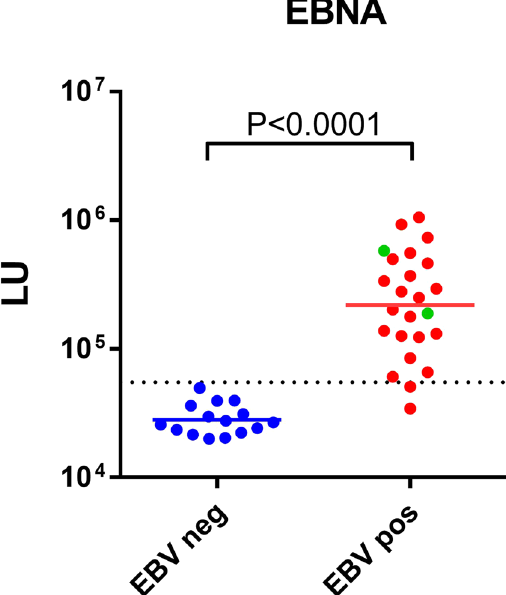
Figure 4. Diagnosis of EBV infection by LIPSTICKS. A cohort of human samples characterized for EBV infection by a commercial ELISA detecting antibodies directed against the capsid protein (VCA) was employed for LIPSTICKS testing. An EBV EBNA luciferase antigen in ultrarapid format showed general concordance with the ELISA for detecting EBV negative (blue) and EBV positive (red) individuals. However, two samples positive (green) by LIPSTICKS, but seronegative by the ELISA were further studied and confirmed to be true-EBV seropositive samples. The geometric mean (solid colored line) and the cut-off value (dotted line) are shown. P values were calculated using the Mann-Whitney U